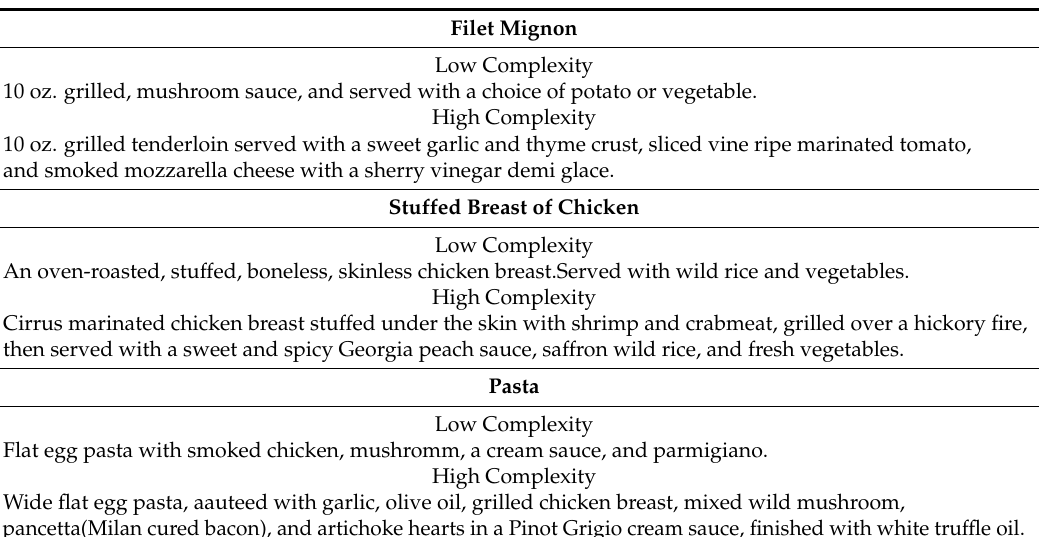
Table 1. Simple and complex menu item descriptions from McCall & Lynn’s (2008) study